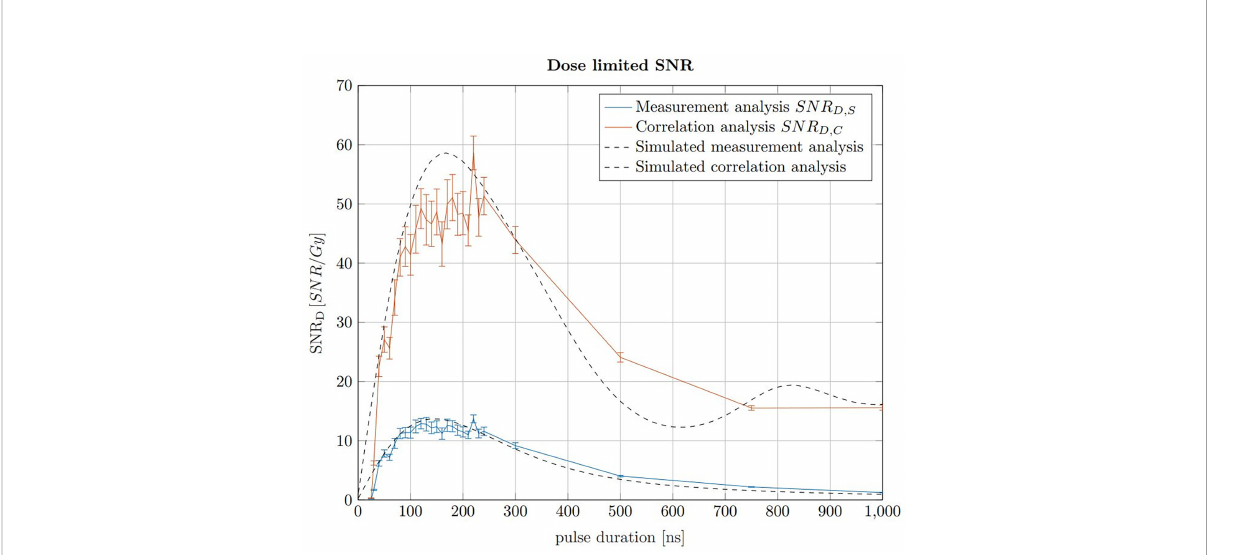
FIGURE 7 SNR D,S of raw signals in blue and the SNR D,C of the corresponding correlations in red for 20 MeV protons and a constant instantaneous beam current (4.5 m A). The error bars are given as the SEM after 20 independent evaluations. The black curves show simulations of the measured data, which have been scaled to match the measured